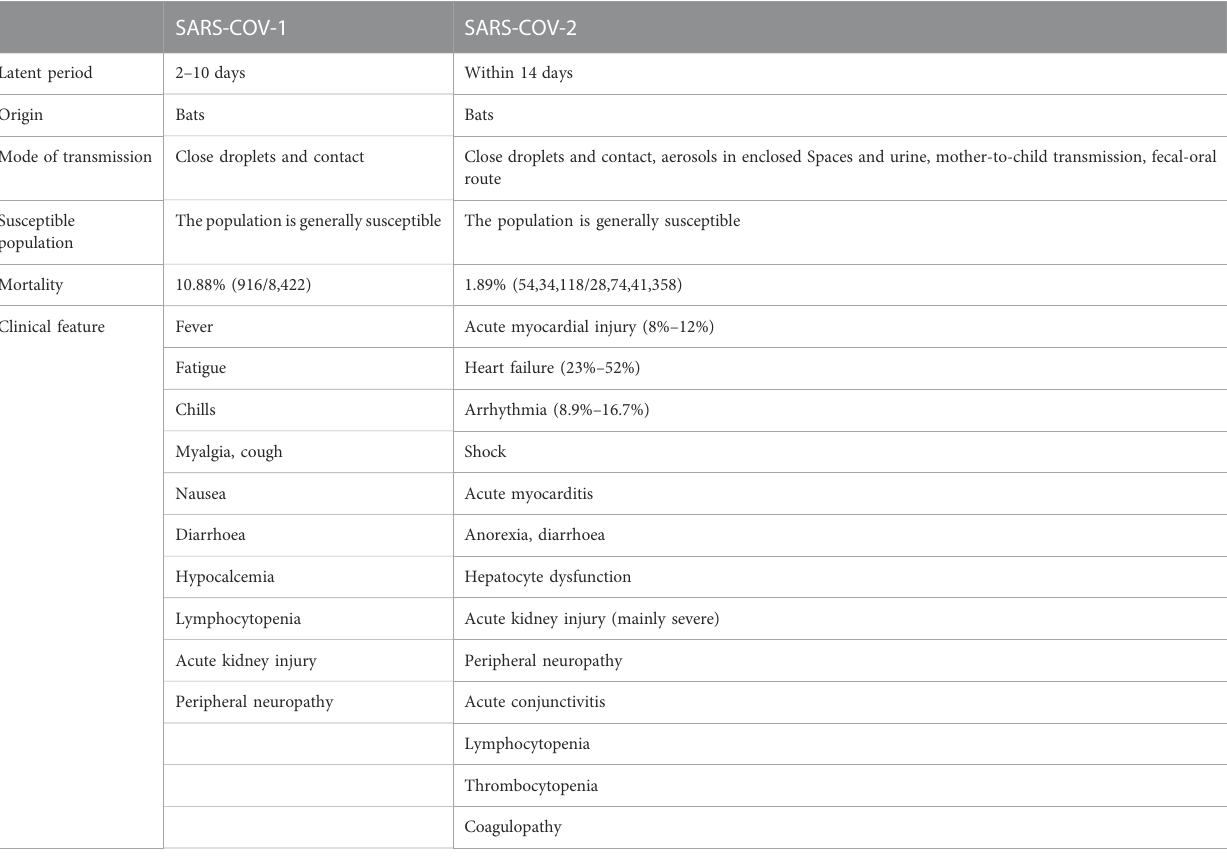
TABLE 1 Comparison of the characteristics of two coronaviruses.